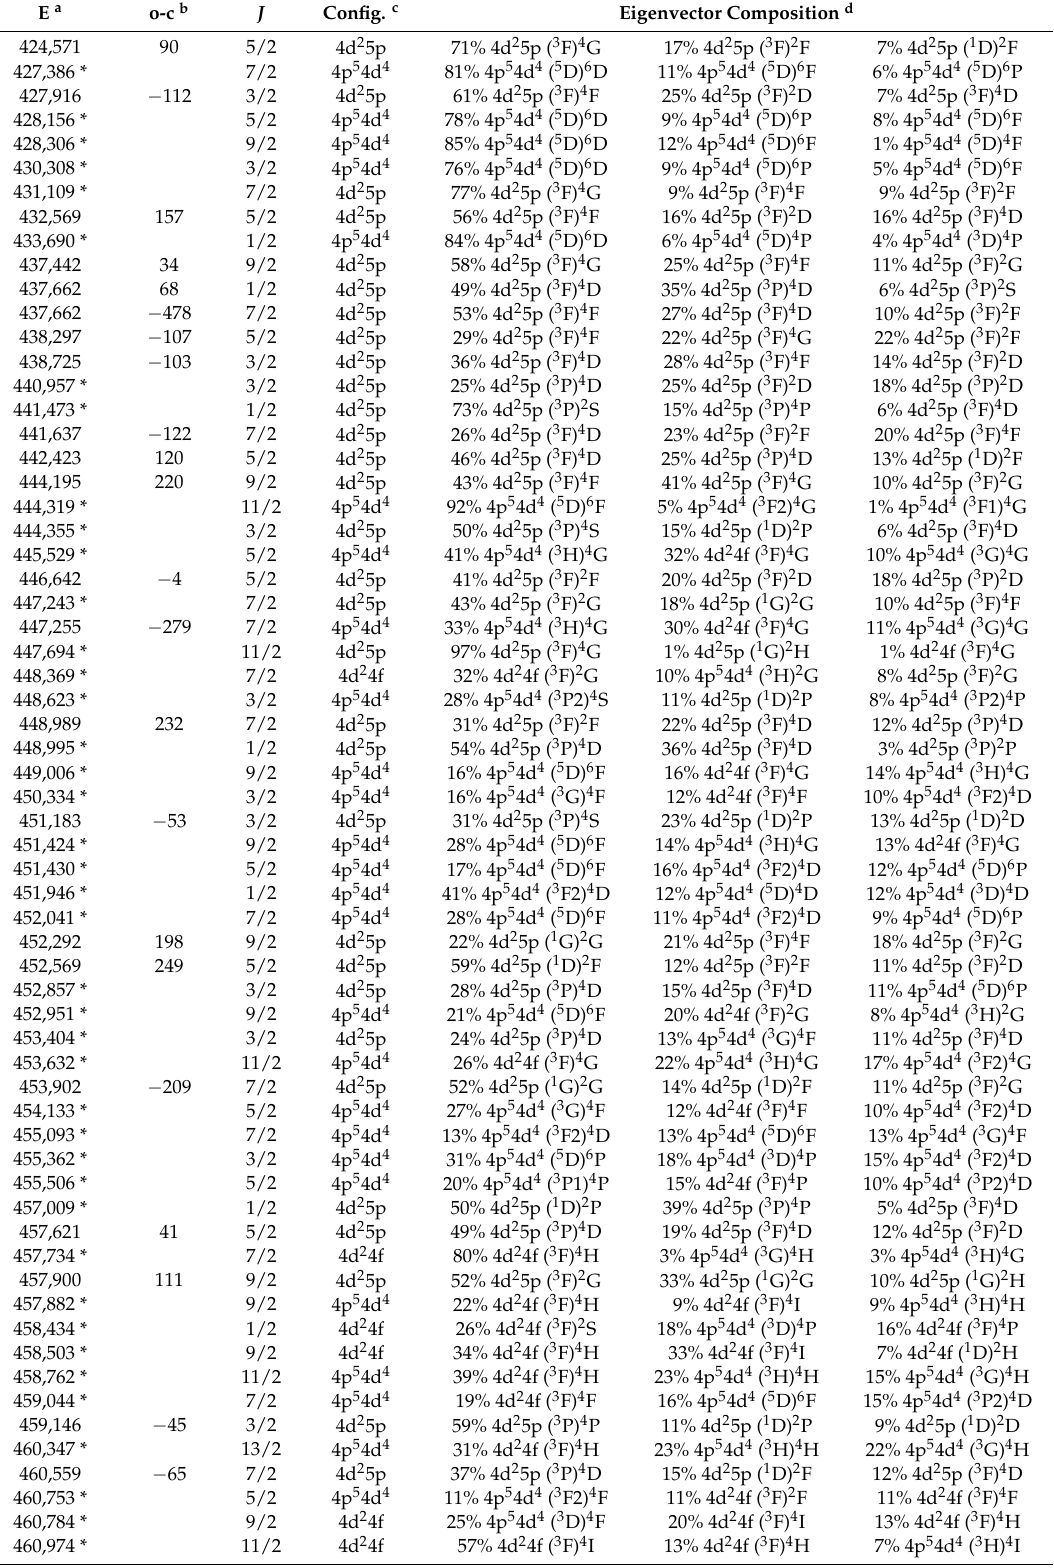
Table A11. Energies (in cm − 1 ) of the 4d 2 5p + 4d 2 4f + 4p 5 4d 4 configurations of Ag